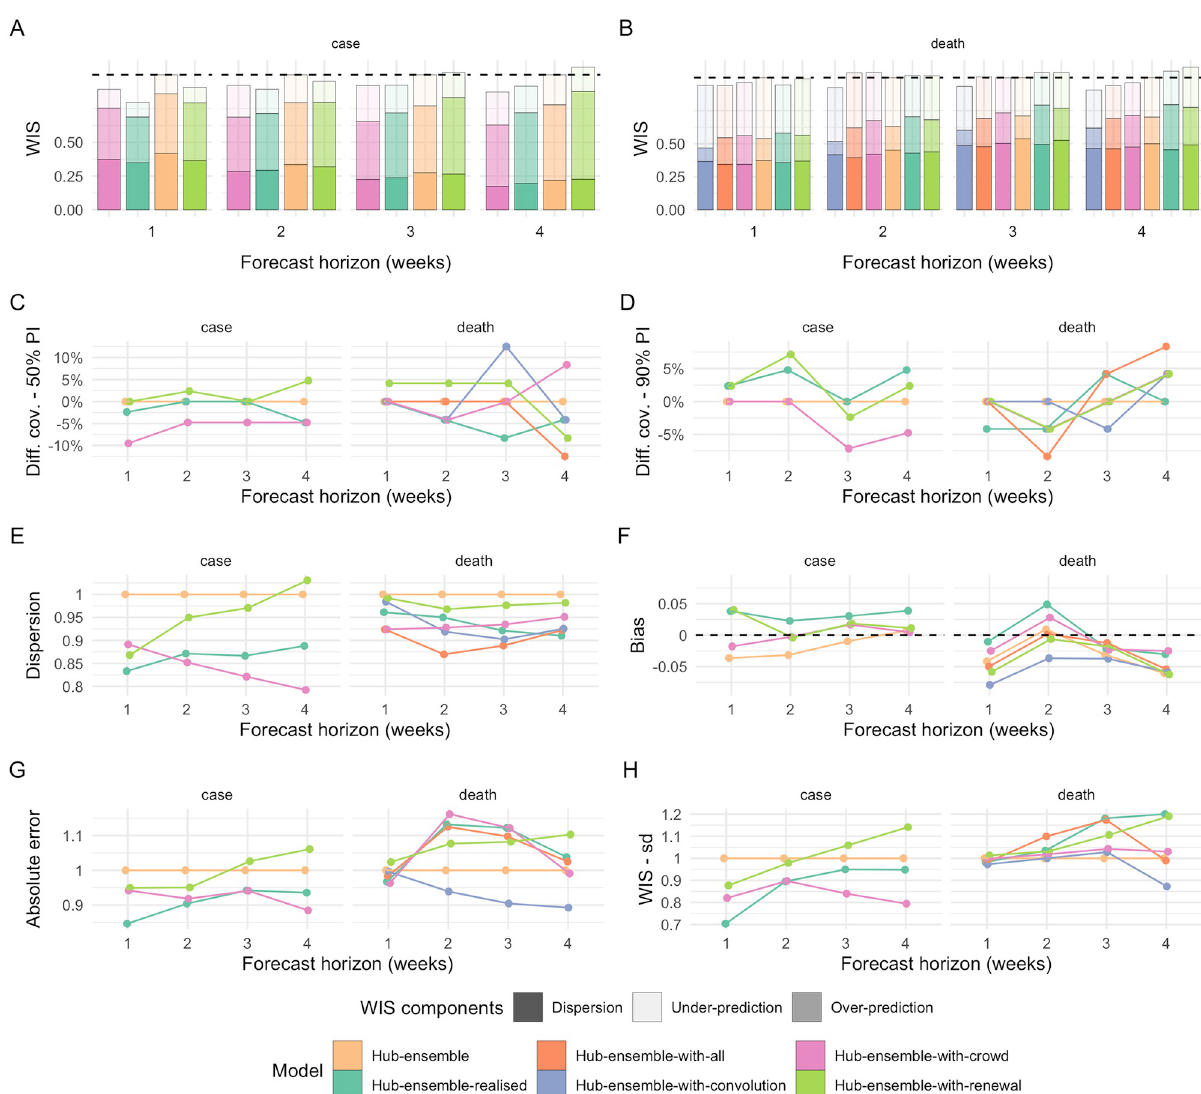
Fig 4. Relative aggregate performance metrics across forecast horizons for different versions of the Hub median ensemble. “Hub-ensemble” excludes all our models, Hub-ensemble-all includes all of our models, “Hub-ensemble-realised” is the actual hub-ensemble observed in reality, which includes the renewal model and the crowd forecasts, but not the convolution model. A, B: mean weighted interval score (WIS) across horizons relative to the Hub ensemble (lower values indicate better performance). C, D: Empirical coverage of the 50% and 90% prediction intervals minus empirical coverage observed for the Hub ensemble. E: Dispersion relative to the dispersion of the Hub ensemble. Higher values mean greater dispersion of the forecast and imply ceteris paribus a worse score. F: Bias, i.e. general (relative) tendency to over- orunderpredict. Values are between -1 (complete under-prediction) and 1 (complete over-prediction) and 0 ideally. G: Absolute error of the median forecast relative to the Hub ensemble. H. Standard deviation of all WIS values for different horizons relative to the Hub